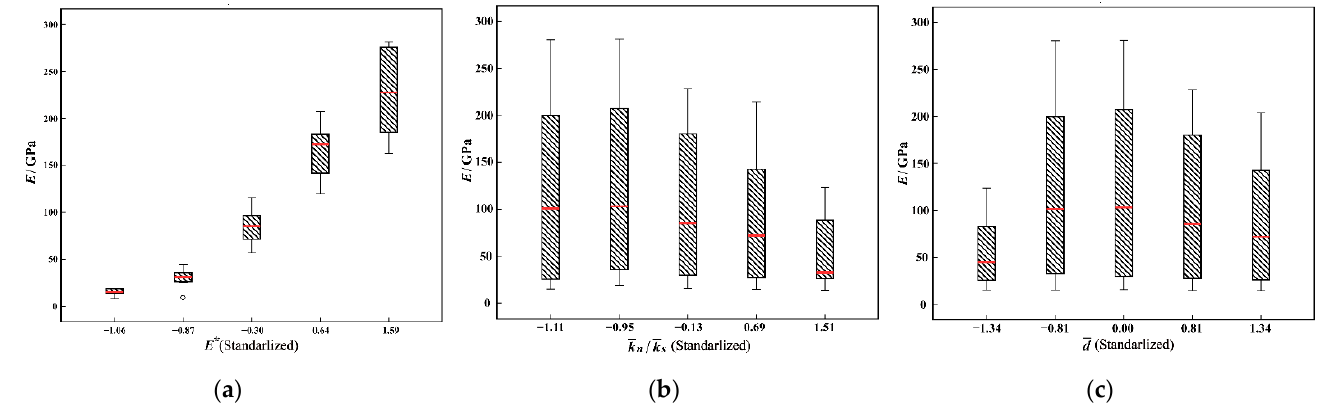
Figure 8. Boxplot between elastic modulus and meso parameters: ( a ) Equivalent modulus and parallel bond equivalent modulus; ( b ) Parallel bond stiffness ratio; ( c ) Control gap of parallel